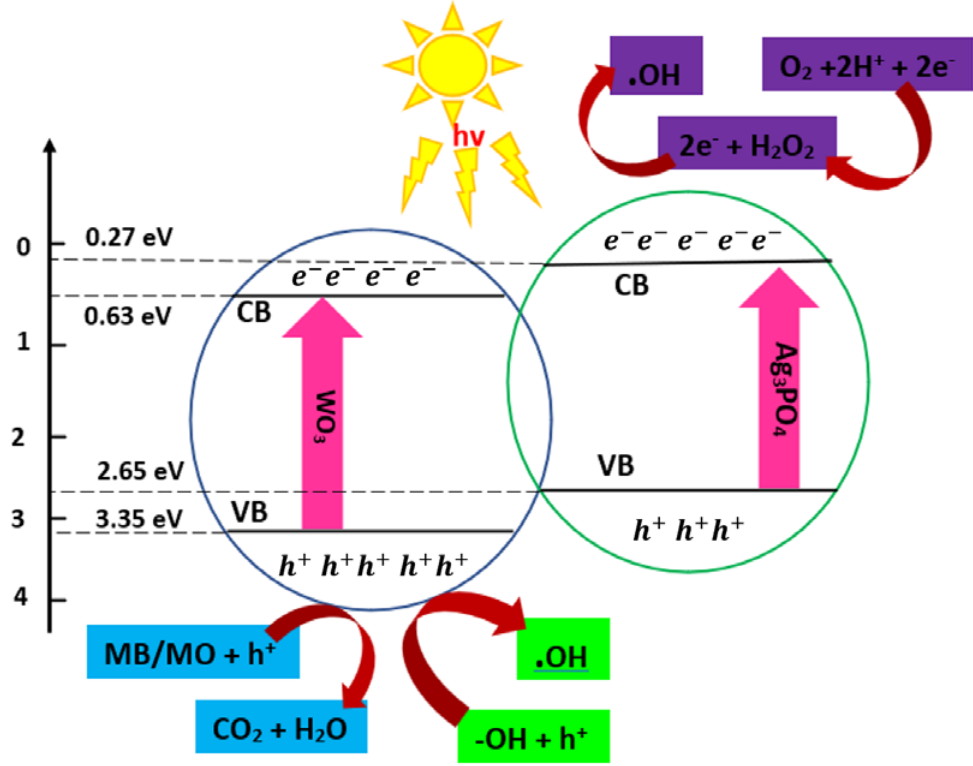
Figure 14. The organic dye degradation by the WO 3 /Ag 3 PO 4 heterojunction semiconductor and the related mechanism.